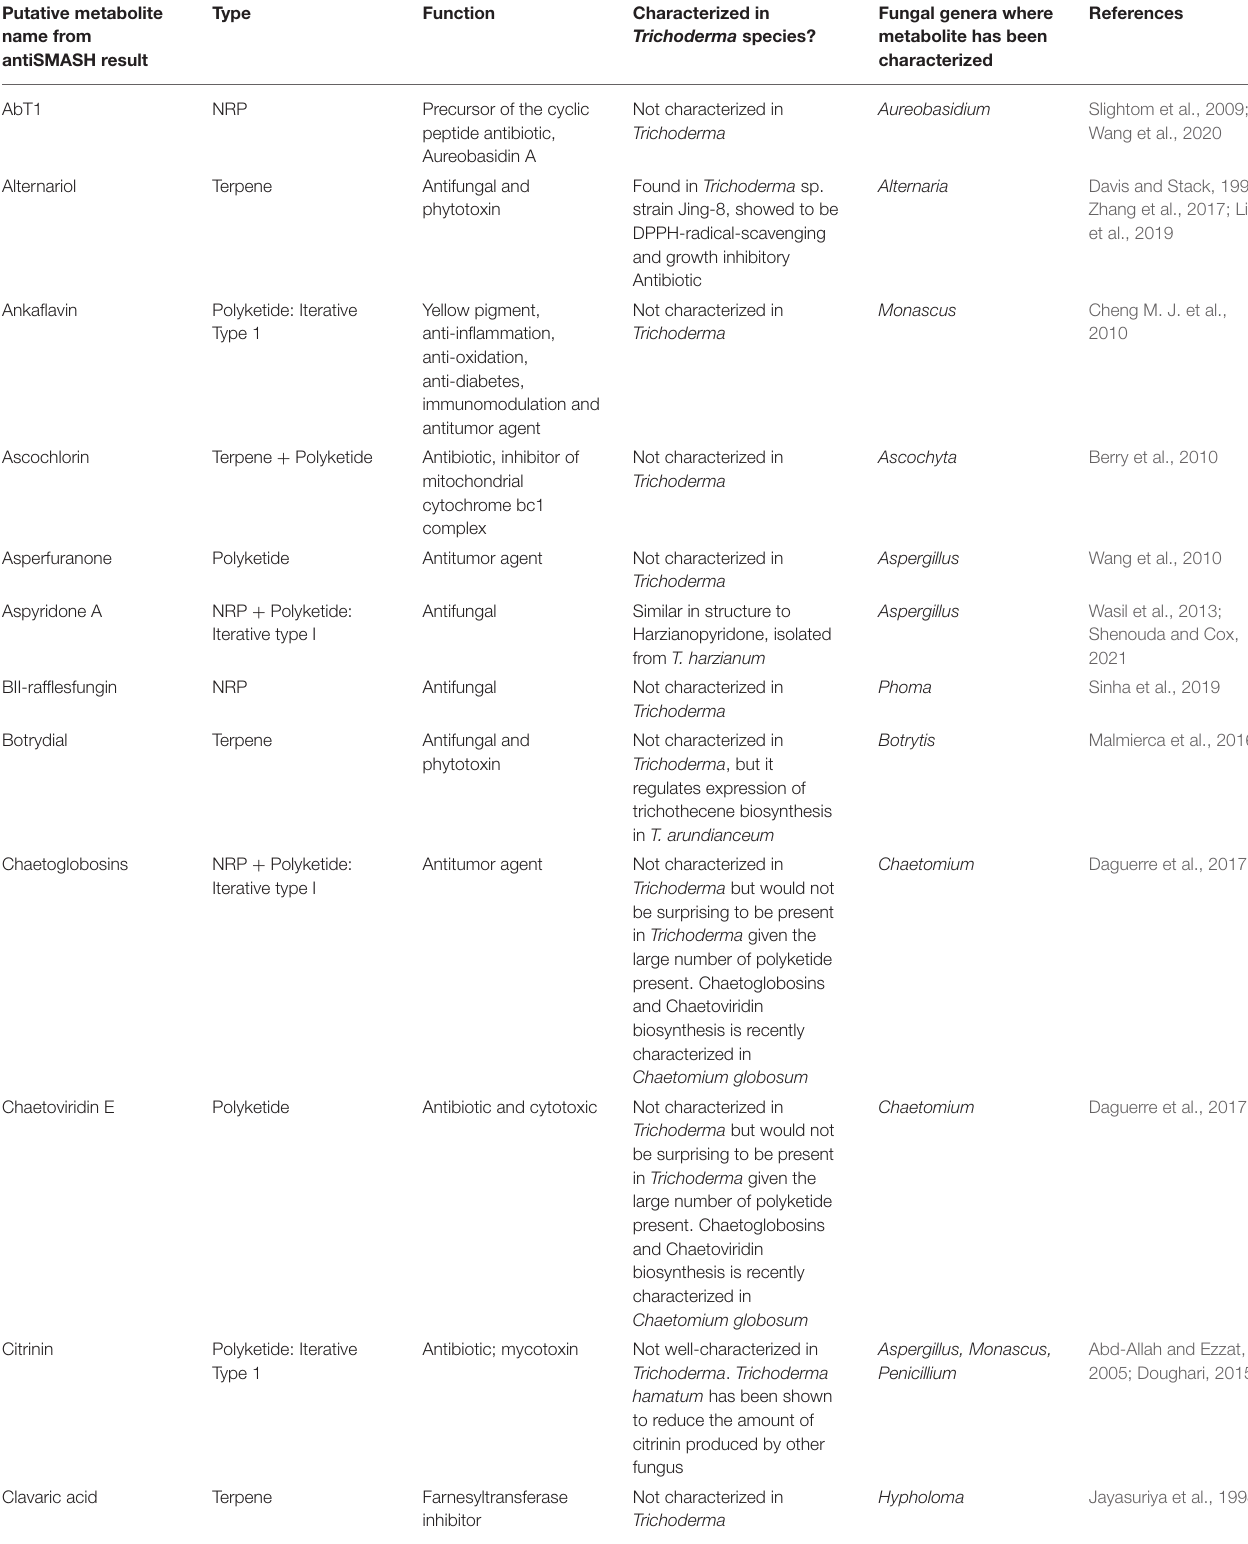
TABLE 2 | A descriptive list of putative metabolites predicted from antiSMASH based on screening Trichoderma genomes. Putative metabolite name